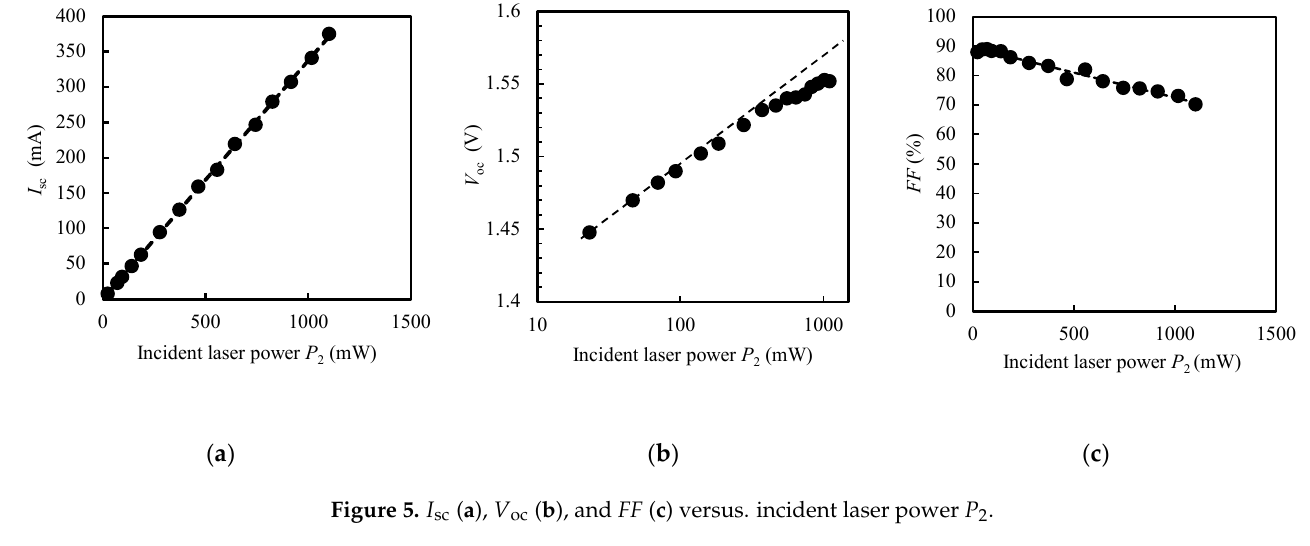
Figure 5. I sc ( a ), V oc ( b ), and FF ( c ) versus. incident laser power P 2 .